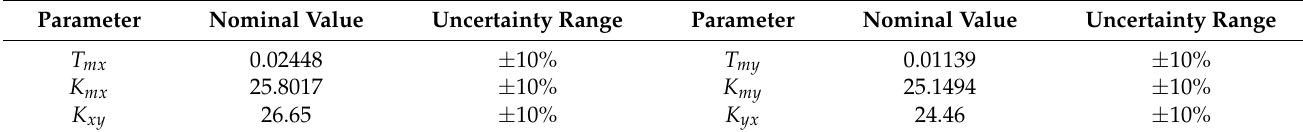
Table 1. Nominal values and uncertainty ranges of the CNC model parameters.